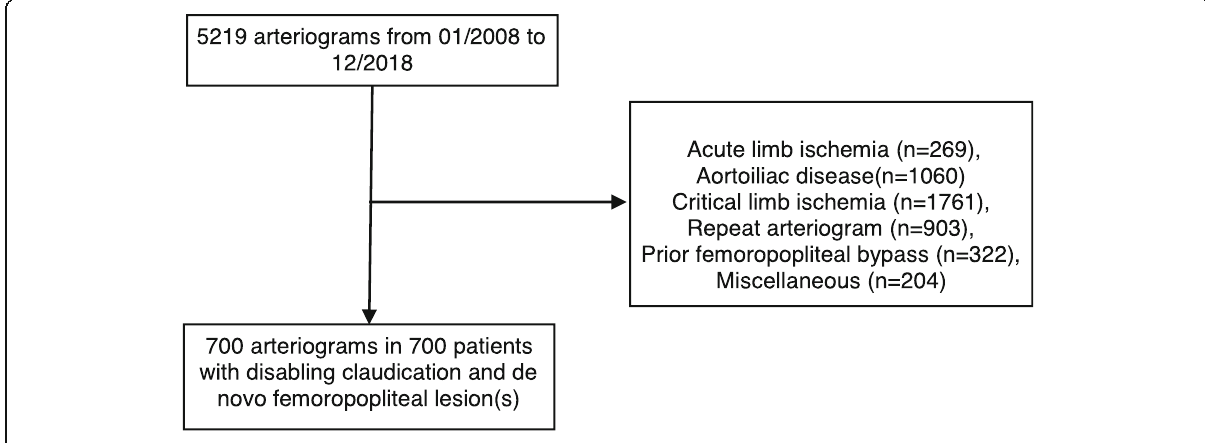
Fig. 1 Flow chart of the selection of the patients included in the study